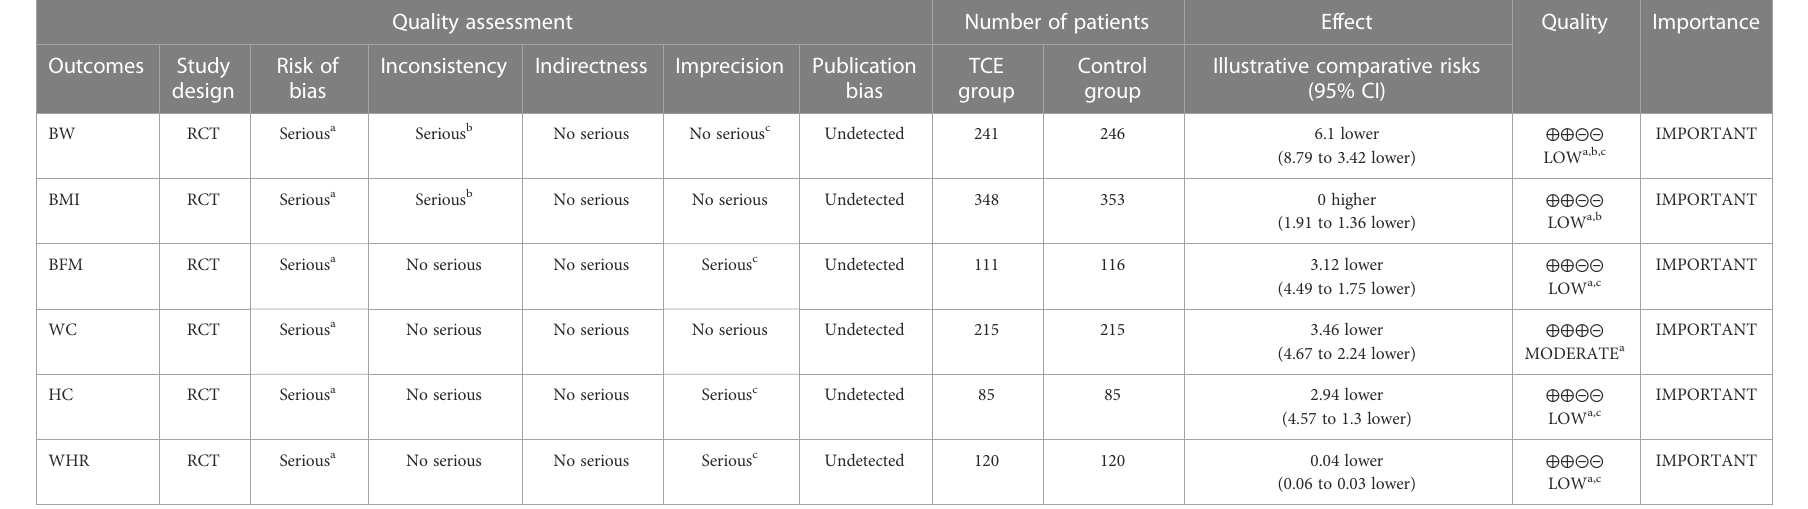
TABLE 3 Summary of